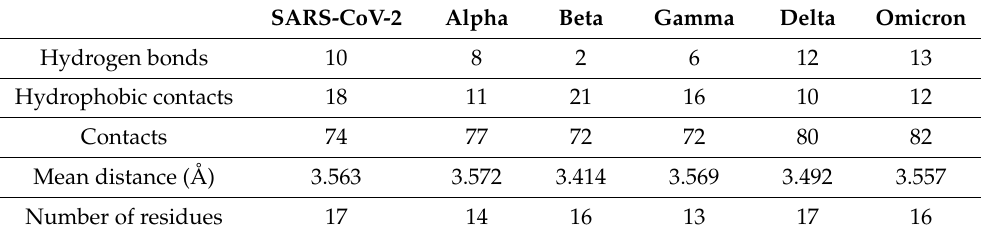
Table 3. Properties of the interaction between RBDs of the VOCs and the receptor. SARS-CoV-2 Alpha Beta Gamma Delta Omicron Hydrogen bonds 10 8 2 6 12 13 Hydrophobic contacts 18 11 21 16 10 12 Contacts 74 77 72 72 82 Mean distance (Å) 3.563 3.572 3.557 Number of residues 17 14 16 13 17